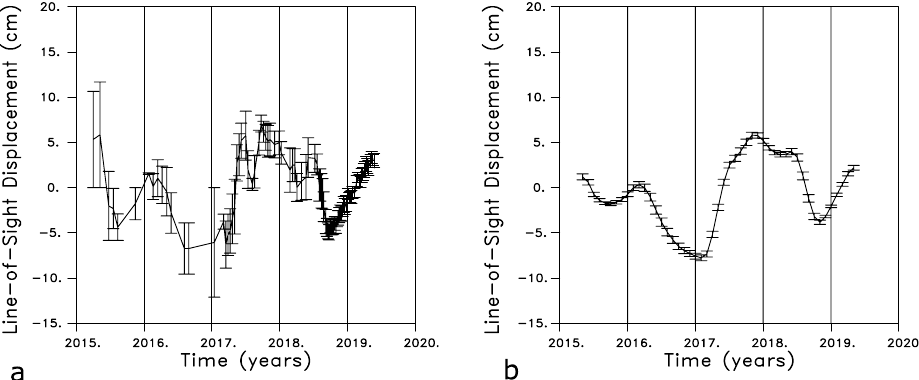
Figure 3. ( a ) Mean values for the reduced line-of-sight displacement with the quadratic fit removed [see Fig. 2c]. The values were obtained by averaging over a sliding three month window. The time series corresponds to the line-of-sight displacement for a point mid-way between Lemoore and Corcoran. ( b ) Time series obtained after averaging over 2 km by 2 km spatial bins. The error bars represent the one standard error about the mean value, obtained from the individual contributions to the bin average. The estimates are for the point denoted by the filled green circle in Fig.